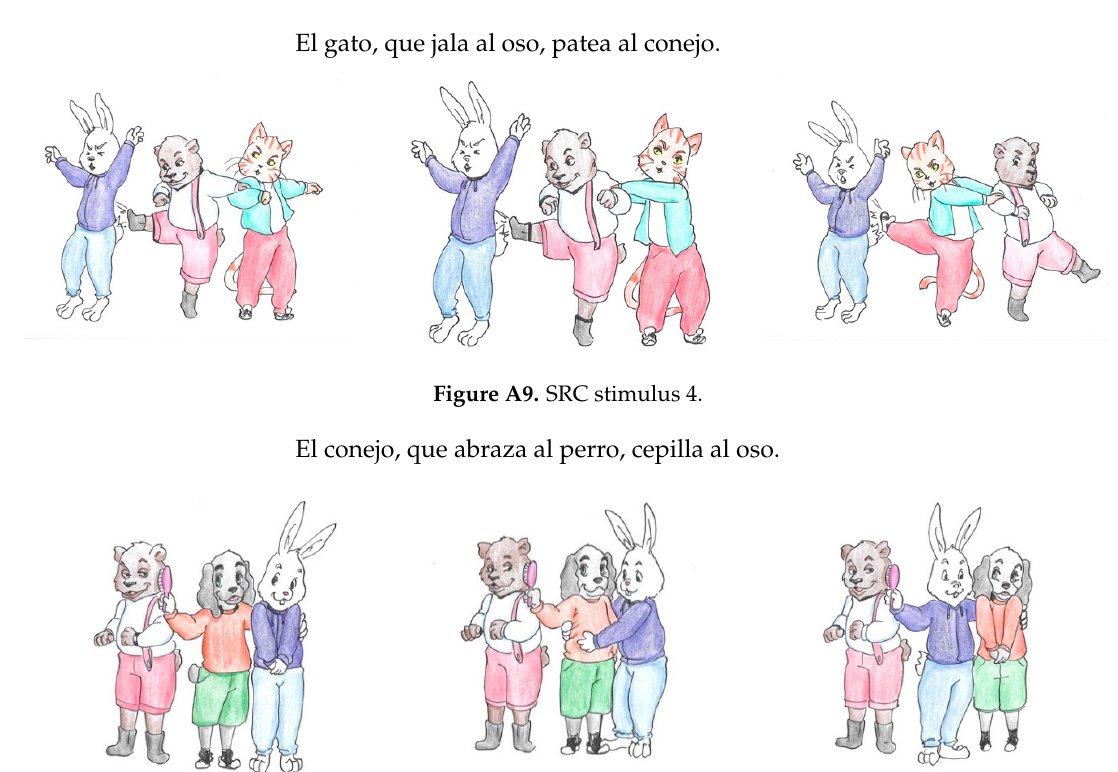
Figure A8. SRC stimulus 3.